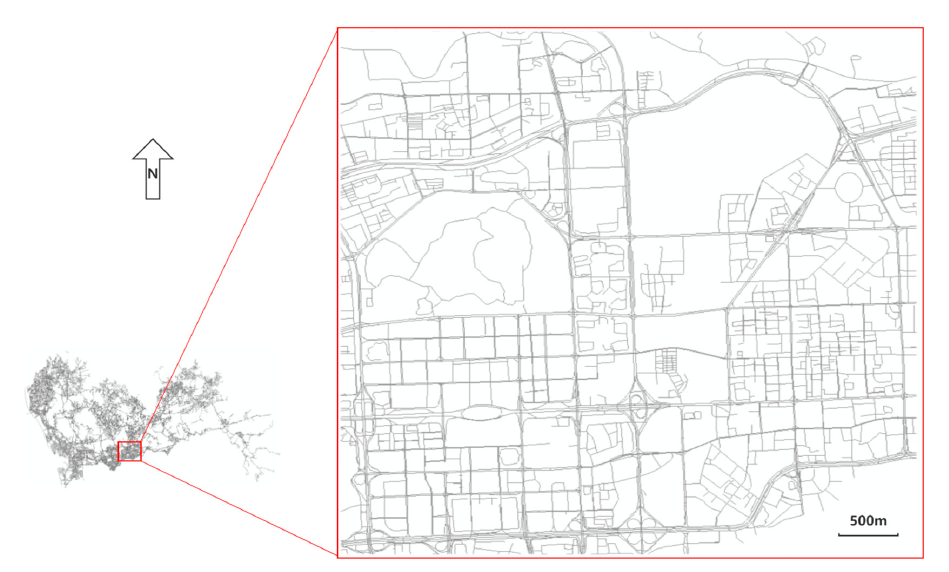
Figure 7. Study area of Shenzhen map.